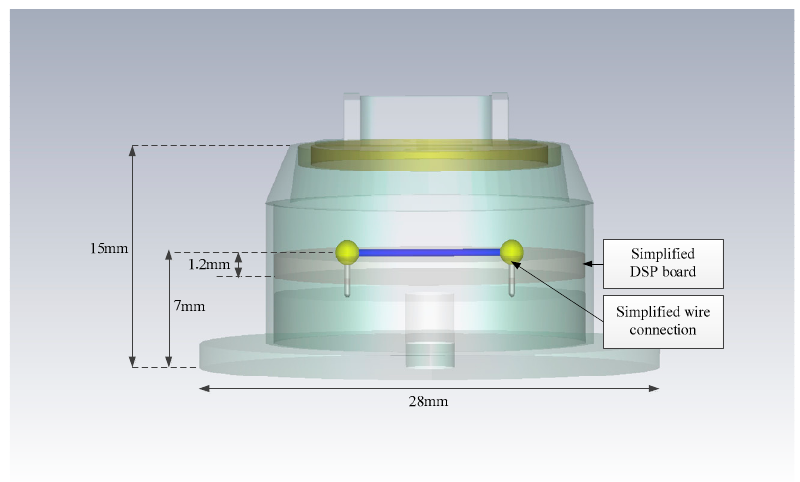
Figure 6. The internal structure of the field model.